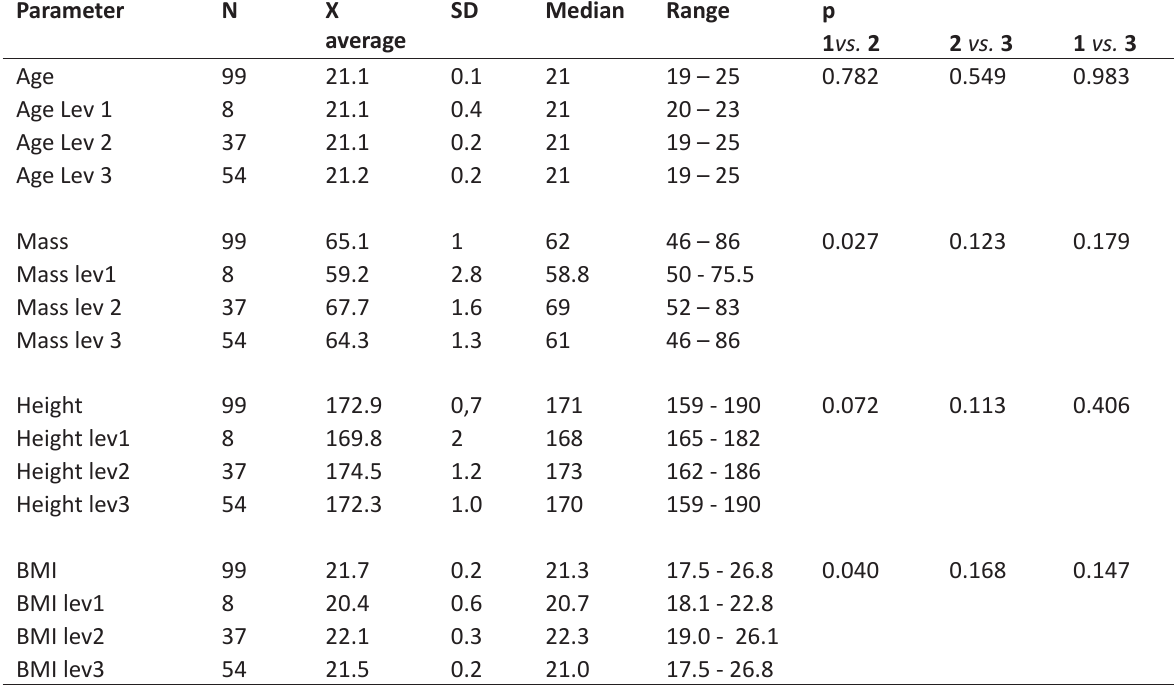
Table 4. Correlation of the age, weight, height, and BMI vs. level of activity